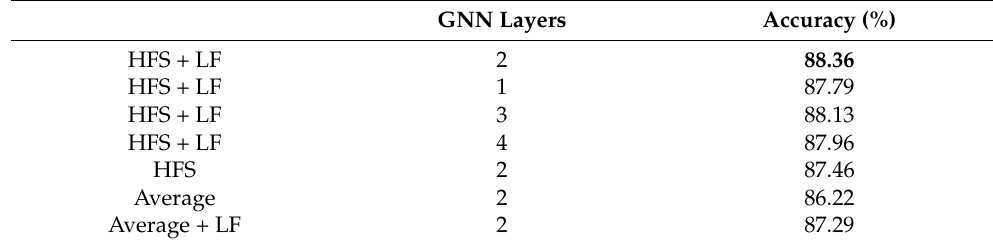
Table 7. Further ablation study of HFGNN-Proto on ARSC. LF stands for linear function. Average means that the average strategy is used instead of HFS to handle the